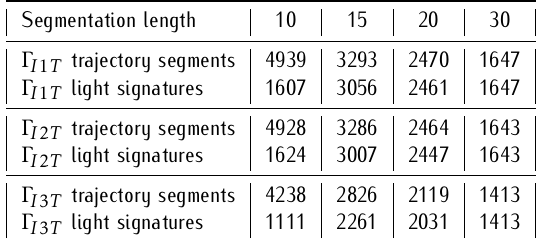
Table 8. Number of light intensity segments and unique light signatures with various segmentation lengths for Deva to Pites (via Sibiu) trajectory